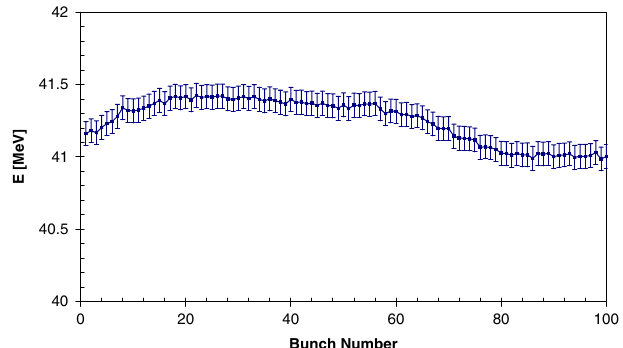
FIG. 11. Beam loading for 41 MeV, 50 nC in 100 bunches.